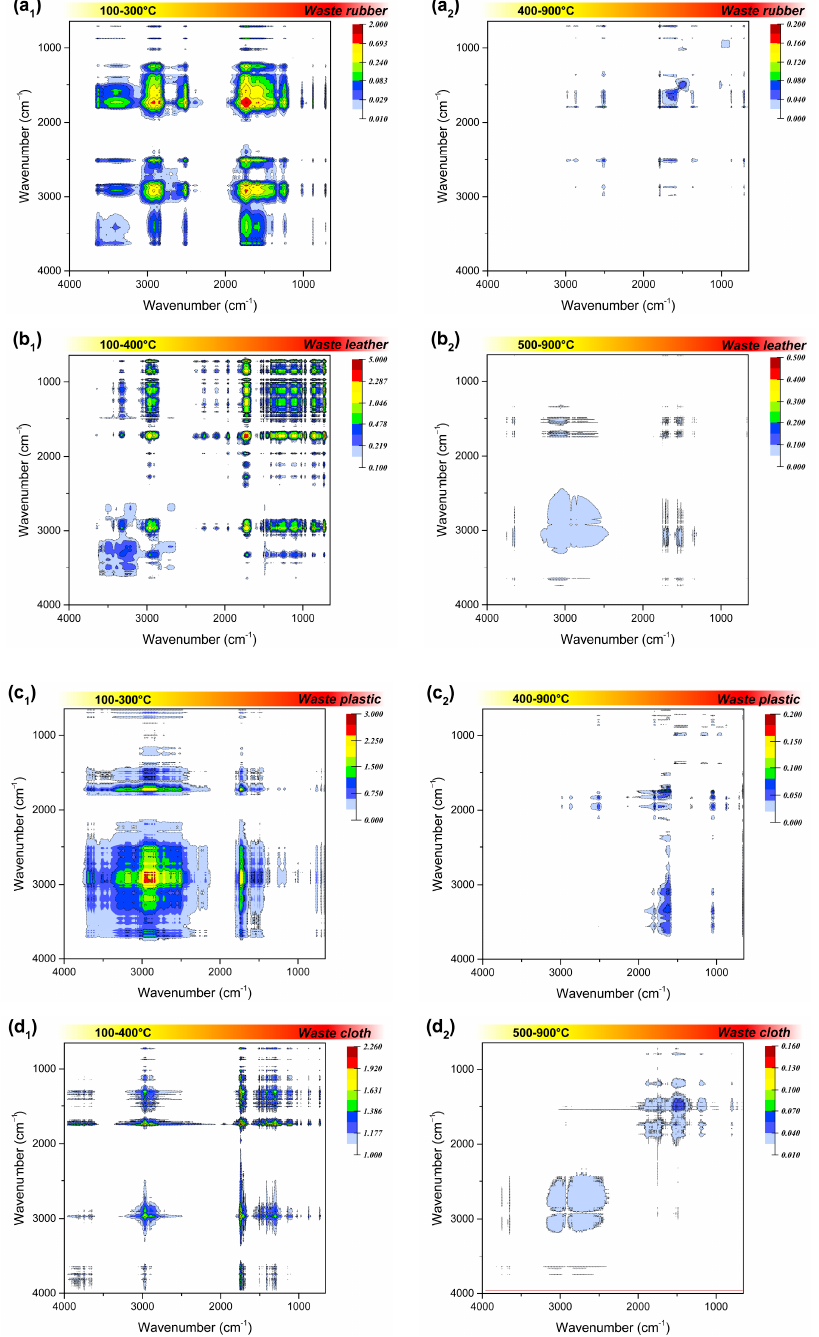
Figure 5. Synchronous two-dimensional correlation spectrum in 4000–650 cm − 1 of the four polymeric wastes before ( a 1 , b 1 , c 1 , d 1 ) and after ignition ( a 2 , b 2 , c 2 , d 2 ).